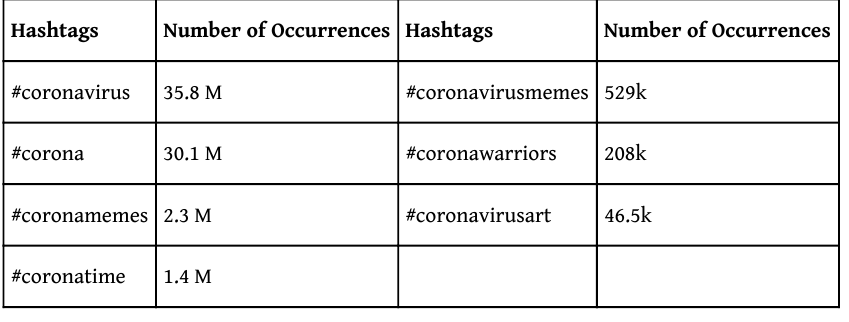
Hashtags Number of Occurrences